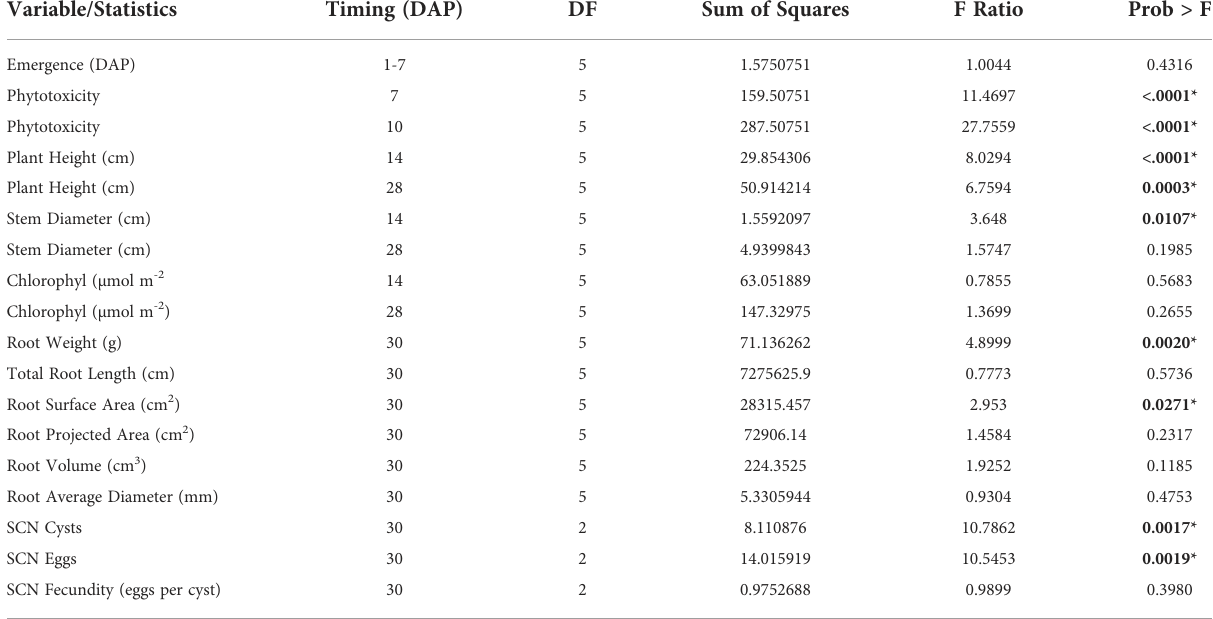
TABLE 2 ANOVA (Analysis of variance) table indicating the effect of seed treatments on plant growth, root parameters, and SCN counts.